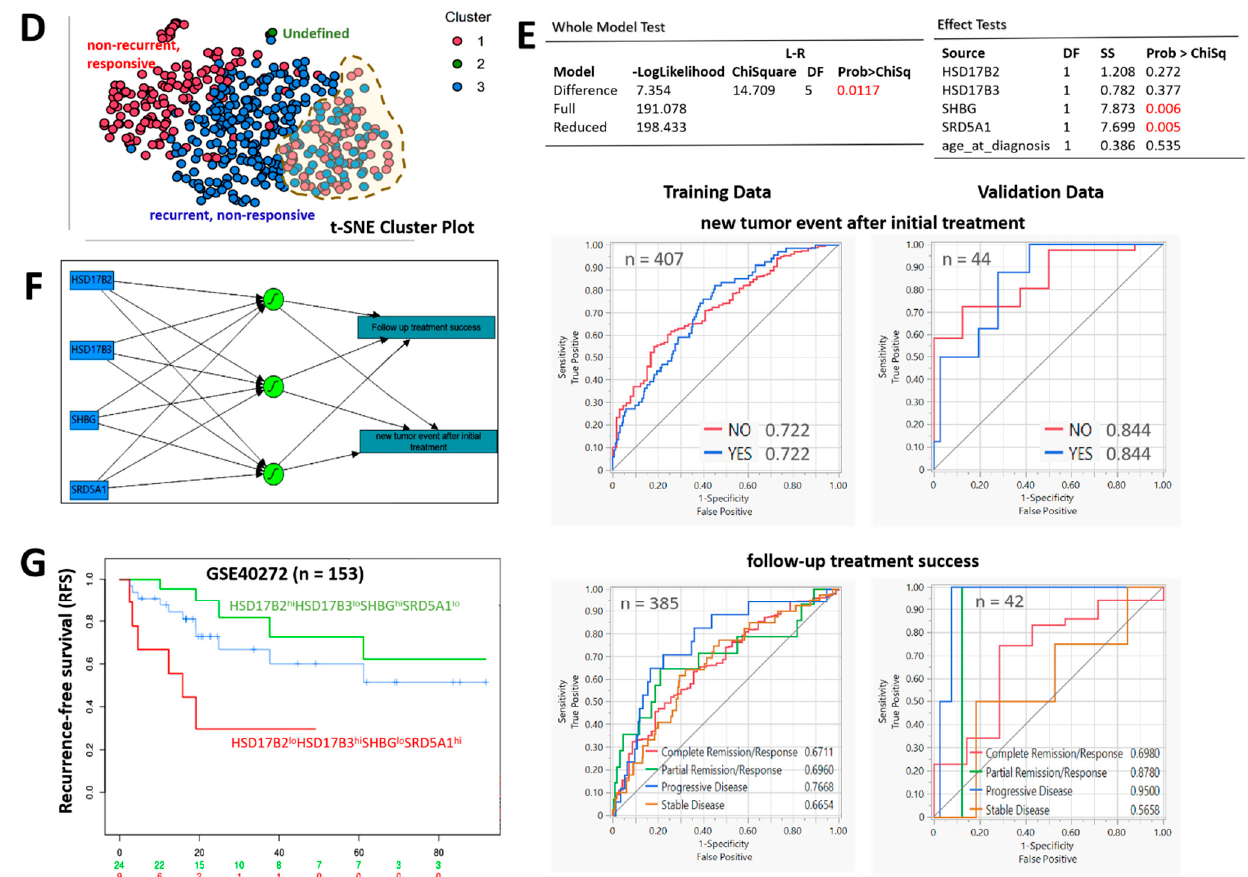
Figure 6. Compared with PSA, the HSD17B2/HSD17B3/SHBG/SRD5A1 4-gene signature is capable of differentiating recurrent/nonresponsive from nonrecurrent/responsive PCa. ( A ) Graphical representation of the probability of including SRD5A1, SHBG, HSD17B2, HSD17B3, PSA value, or age at diagnosis as predictors of recurrence/new tumor event after initial treatment. ( B ) Histograms of cluster mean plots of all potential predictors. ( C ) Cluster density plots using HSD17B2 (ENSG00000086696.9), HSD17B3 (ENSG00000130948.8), SHBG (ENSG00000129214.13), SRD5A1 (ENSG00000145545.10), PSA value, and age at diagnosis. Clustering is based on k-means. ( D ) t-SNE cluster plot showing stratification of the TCGA PRAD cohort into nonrecurrent, responsive or recurrent (cluster 1), nonresponsive clusters (cluster 2), and undefined (cluster 3). ( E ) Prediction profiler based on generalized linear model showing correlation between HSD17B2, HSD17B3, SHBG, SRD5A1, or age at diagnosis and new tumor event after initial treatment (upper). AUROC analysis showed that the testosterone tetrad predicts new tumor event after initial treatment (middle), and follow-up treatment success (low). AUROC, area under the receiver operating curve; t-SNE, t-distributed stochastic neighbor embedding. ( F ) Pictorial visualization of the Artificial neural network (ANN) model, showing the input nodes HSD17B2, HSD17B3, SHBG, and SRD5A1 interacting to generate the output nodes “new tumor event after initial treatment” and “follow-up treatment success”. Three hidden nodes are empirically generated. ( G ) Kaplan-Meier curve showing the differential effect of HSD17B2 lo HSD17B3 hi SHBG lo SRD5A1 hi and HSD17B2 hi HSD17B3 lo SHBG hi SRD5A1 lo on the recurrence-free survival in the TCGA PRAD